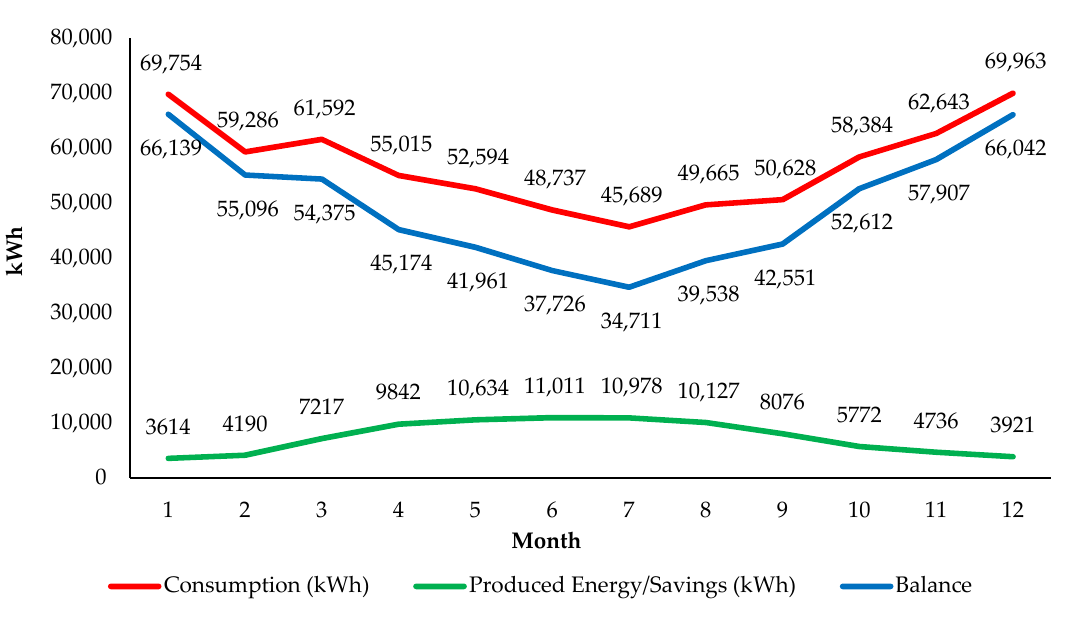
Figure 12. Monthly energy balance.